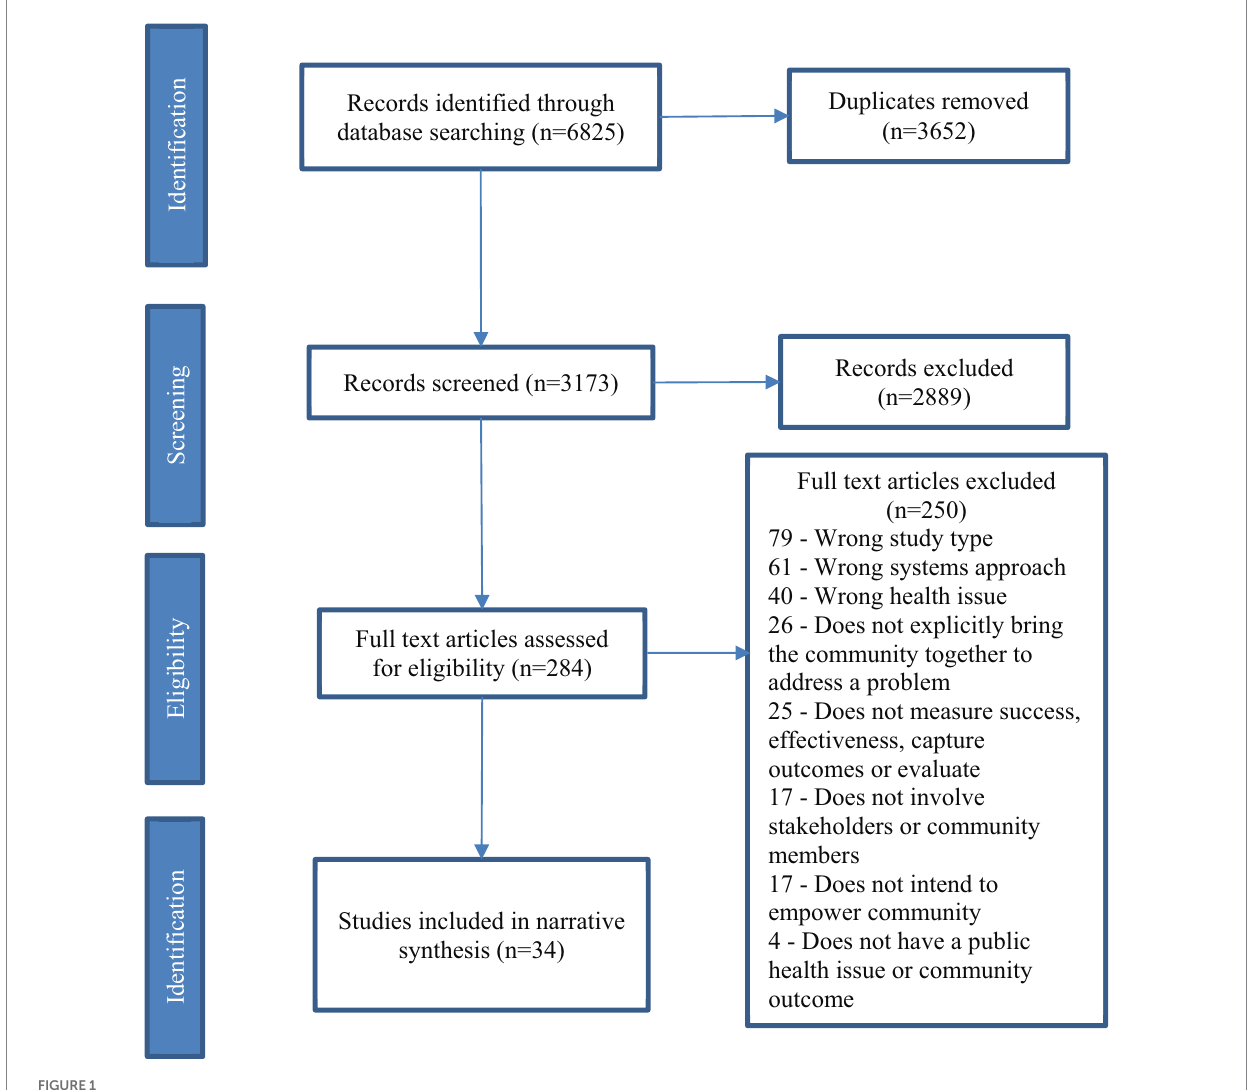
FIGURE 1 PRISMA flow